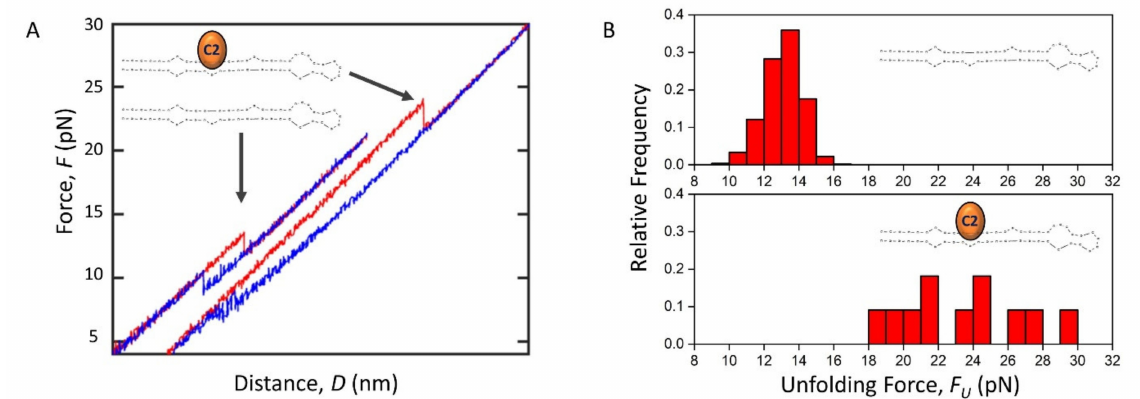
Figure 4. The effect of C2 ligand binding on pre-miRNA-377 unfolding and folding. ( A ) Representative force–distance curves (FDCs) showing the unfolding (red) and folding (blue) of the WT pre-miRNA-377 in absence and presence of 12 µ M C2 ligand (orange) in the Na + /Mg 2+ buffer. ( B ) Unfolding force histograms of the WT pre-miRNA-377 without ligand (top) and in presence of 12 µ M C2 (bottom) in the Na + /Mg 2+